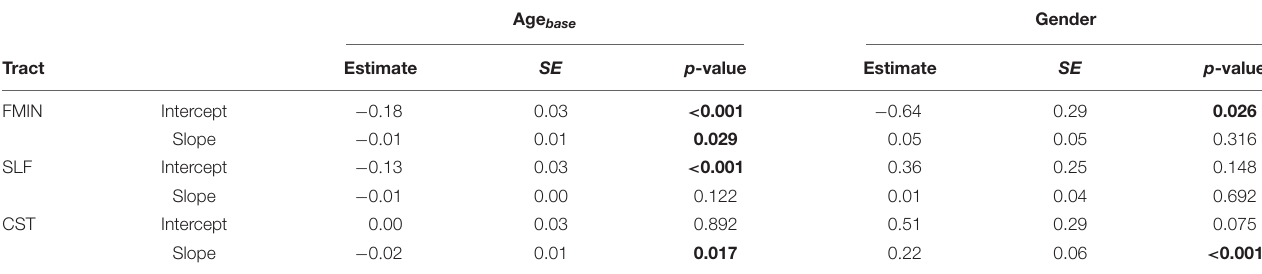
TABLE 4 | Effects of Age at baseline and Gender on intercept and slope of best fitting univariate LGC models for WM